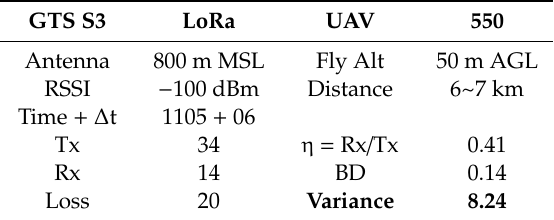
Table 3. Test data at Bai-He (S3).